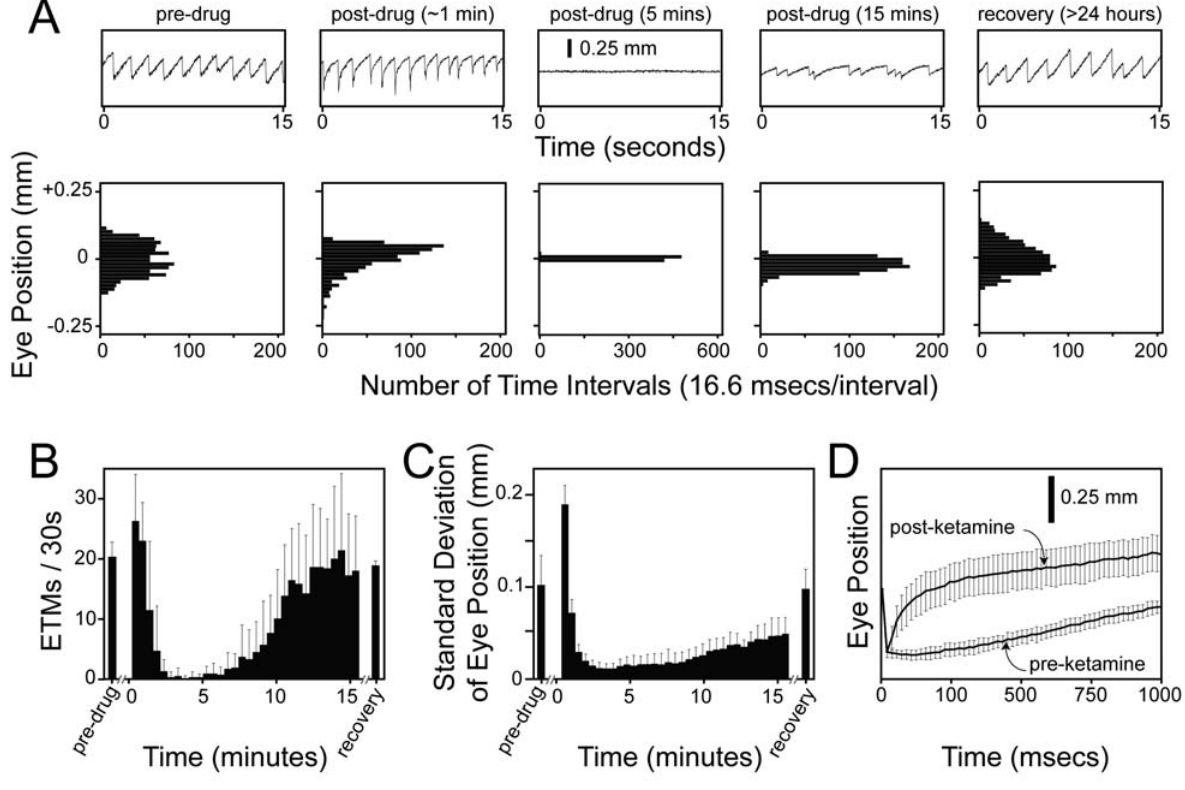
Figure 8. Time course of alterations in the OKR following IP ketamine injection into 129/SvEv mice. (A) Each 15 second ETM record (upper panels), obtained at the indicated time before or after a 75 mg/kg IP ketamine injection, is shown above a histogram of eye positions during the same 15 second interval (lower panels). The histograms were calculated using eye position values sampled at 60 Hz and processed as described under Experimental Procedures. (B) Average and standard deviation of the number of ETMs per 30-second interval following IP ketamine at time 0 (N=5 mice). For panels (B) and (C), the first 30-second interval following ketamine injection begins 15–20 seconds after injection. (C) Average and standard deviation of the standard deviation of eye position for each 30-second interval following IP ketamine at time 0 (N=5 mice). (D) A systematic distortion in the shape of the slow component of the OKR between 45 and 90 seconds after ketamine injection (‘‘post-ketamine’’). The left-most data points in each curve correspond to the start of the slow phase. Note the enlarged time scale on the horizontal axis. (N=22–24 ETMs/averaged curve, obtained from 3 mice.)